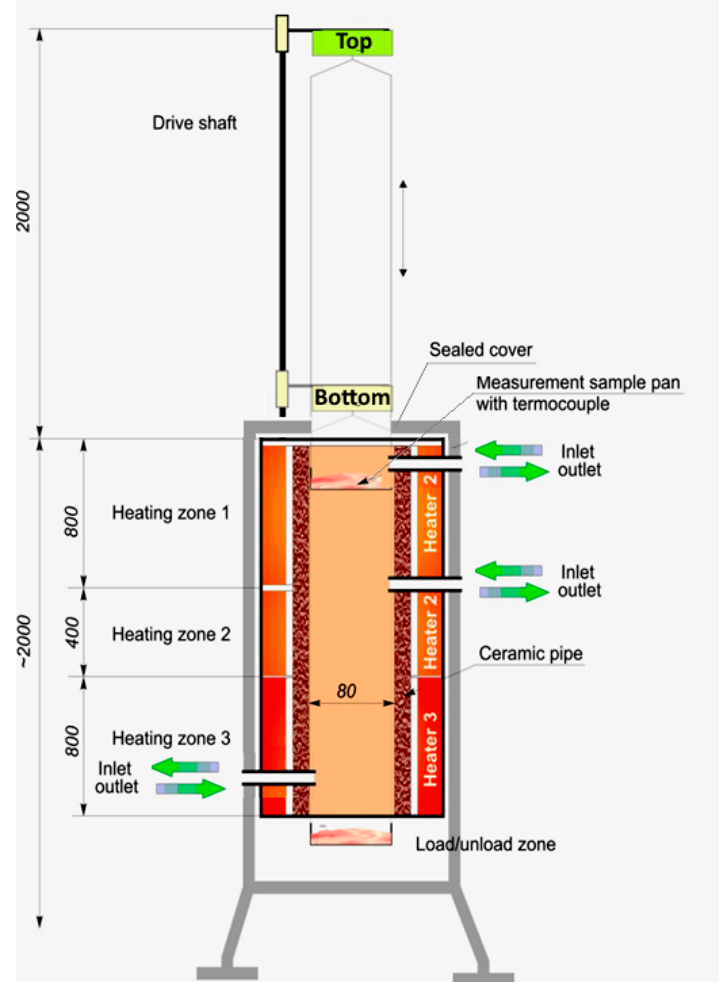
Figure 1. Isothermal furnace - diagram of the experimental rig.